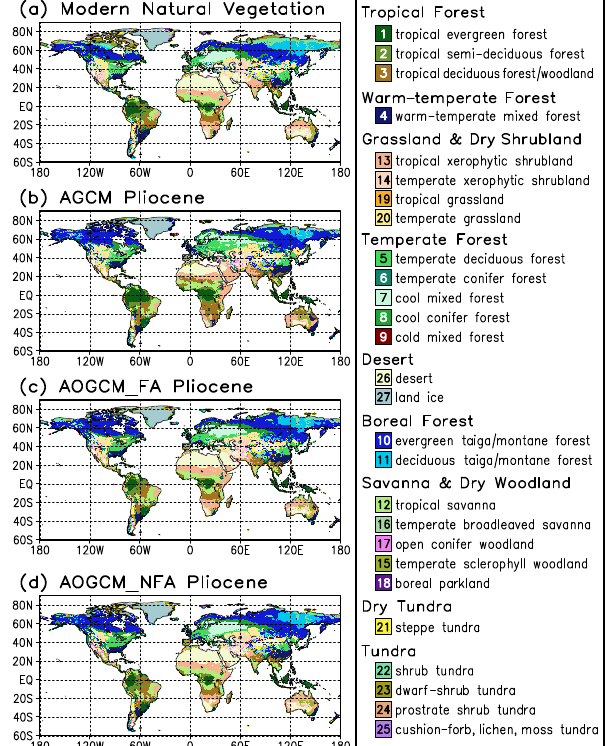
Fig. 8. (a) Difference of sea surface temperature (SST) between Pliocene and Control imposed on AGCM. (b) SST in AOGCM FA and (d) AOGCM NFA. (c) Difference of SST between Pliocene and Control in AOGCM FA and (e) AOGCM NFA. Black and white contours in (a, c, e) represent ± 0, 1.5, 3, 4.5, 6 ◦ C and ± 10, 15 ◦ C, respectively. Black and white contours in (b, d) represent 0, 27, 29 ◦ C and − 1, 30 ◦ C, respectively.